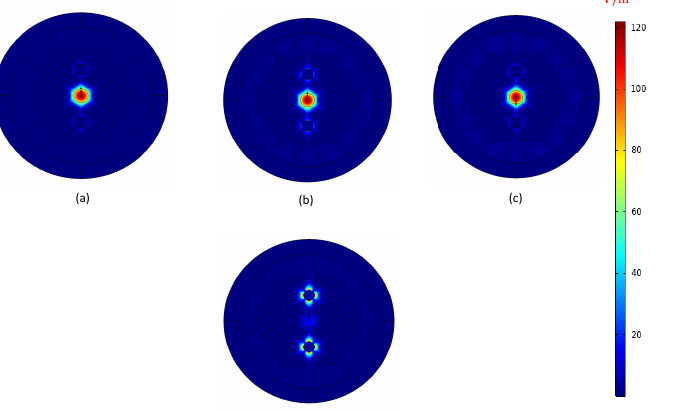
Figure 3. Electric field distributions of the HC-PCF-based SPR sensor for fundamental core mode at ( a ) 1200nm, ( b ) 1244nm (RPW), ( c ) 1300nm and plasmonic mode at ( d ) 1244nm of n a = 1.45.